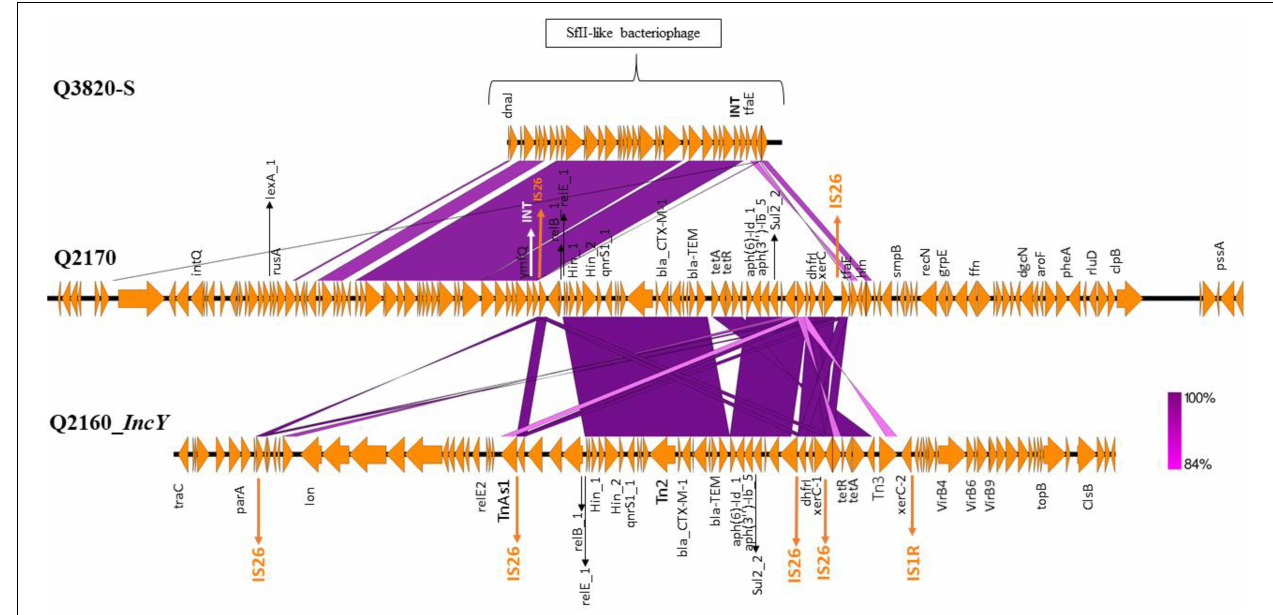
FIGURE 4 | Genomic comparison of the SFII-like bacteriophage region of the 3GC-susceptible Escherichia coli strain (Q3820), the transposon integrated in the SFII-like prophage region of the ST10 3GC-resistant E . coli (Q2170) and the IncY plasmid sequence harboring the same transposon of the ST224 E . coli (Q2160). This comparison shows the putative transfer of resistance genes between these two strains. The figure was made using the Easyfig program.